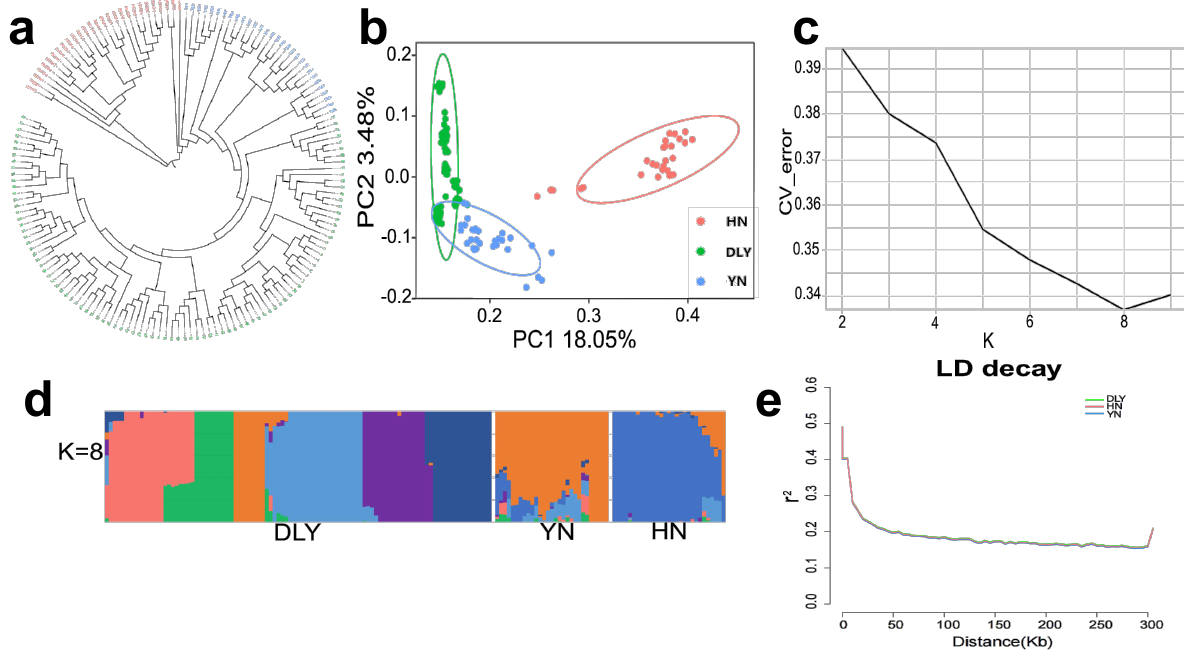
Figure 1. Genomic characteristics of three pig breeds. ( a ) Neighbor-joining (NJ) tree of the after- filtering 157 pigs covering 30 YN black pigs, 28 HN pigs and 99 DLY pigs. Green color: DLY pigs; blue color: YN black pigs; red color: 28 HN pigs. ( b ) Principal component analysis of 30 YN black pigs (blue), 28 HN pigs (red) and 99 DLY pigs (green). ( c ) Ancestral composition analysis K = 2–9. ( d ) Structure analysis with K = 8. ( e ) LD decay in different breeds with 300